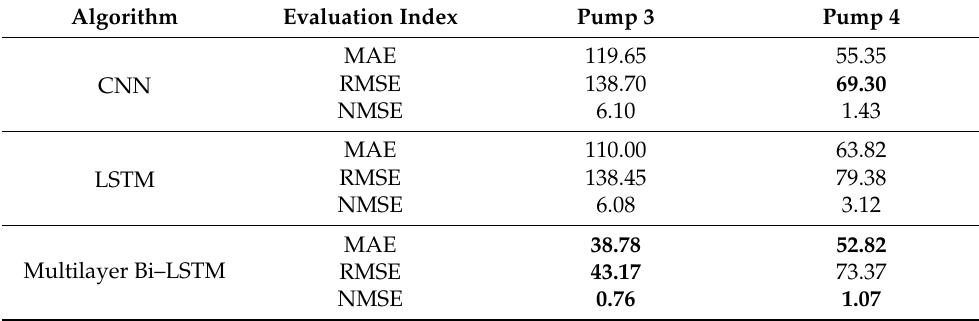
Table 5. Evaluation indexes of the multilayer Bi–LSTM and the comparison algorithms.